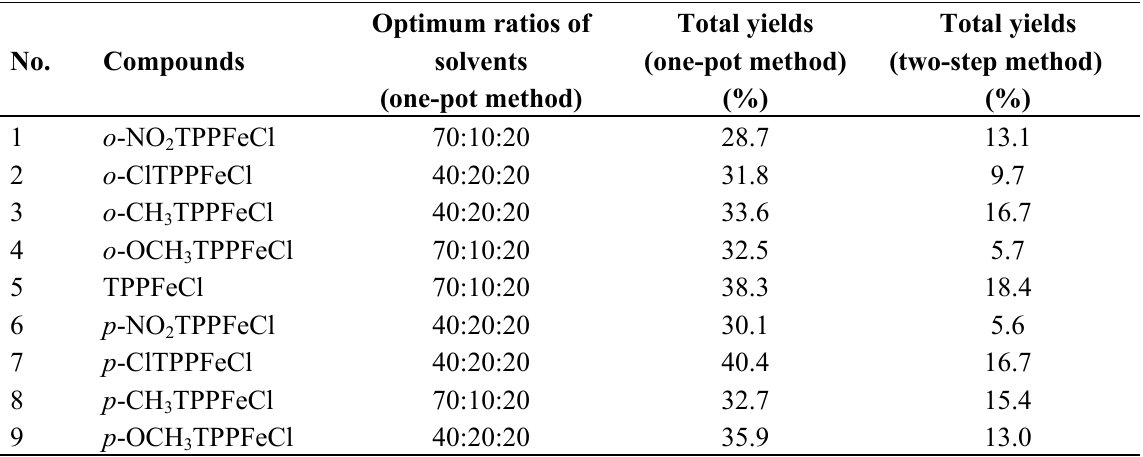
Table 1. Comparison of metalloporphyrin yields by the one-pot and two-step methods. Optimum ratios of solvents: the volume ratios of propionic acid, glacial acetic acid and m